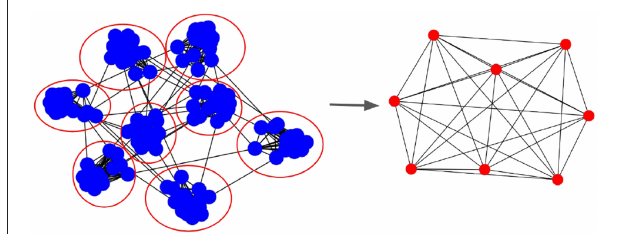
FIGURE 3 | Process Communication Graph (PCG) that represents parallel SNN simulation communication. (Left) The graph with blue nodes represents the SNN synaptic connectivity and the red circles are processes to which the neurons are mapped. (Right) Resulting process graph in which edges represent processes that need to synchronize during simulation, i.e., have an inter-process synaptic connection between themselves. The PCG describes the process neighborhood for each computing node.